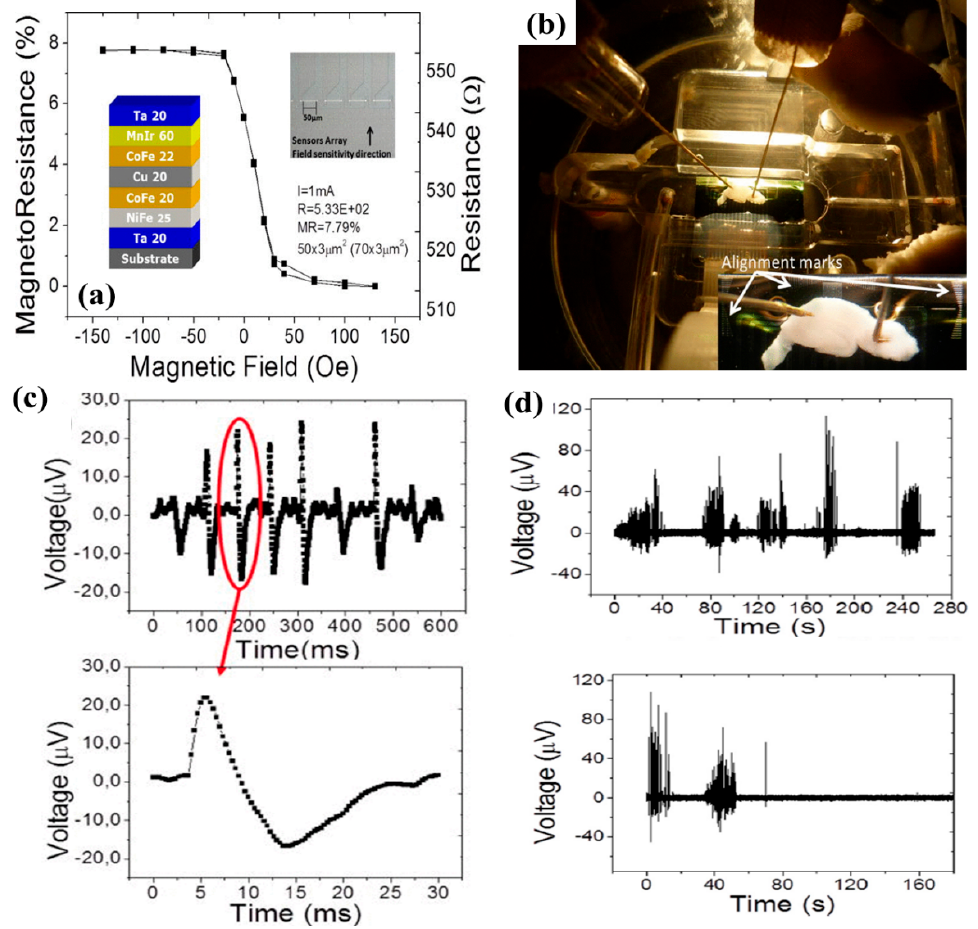
Figure 15. ( a ) The SV-GMR sensor stack arranged in an array of 15 sensors, each of 3 × 15 µ m 2 in cross-section. The R-H curves shows that it is a linear sensor having an MR ratio of 7.8% and a sensitivity of 0.15% / Oe [138]; ( b ) in vitro system set-up for recording neural response from mice hippocampal slices [139]; ( c ) the real-time neural response as recorded from the SV-GMR sensor array [138]; ( d ) GMR sensor recording from the hippocampal slices with (bottom) and without (top) the addition of the tetrodotoxin (TTX) drug, which blocks neural response [138]. Reprinted with permission from AIP Publishing 2011.